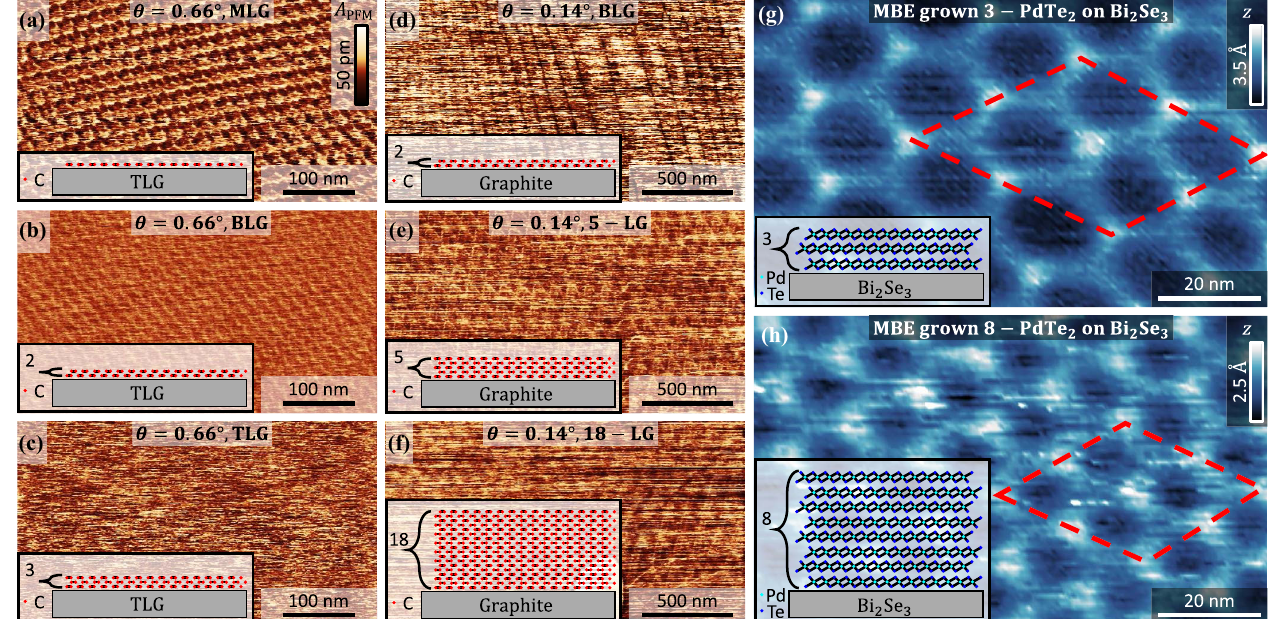
FIG. 2. Experiment motivation: evidence for multilayered relaxation. (a) – (c) PFM amplitude mapping of (a) MLG, (b) BLG, and (c) TLG twisted by 0.65° relative to a TLG substrate. (d) – (f) PFM amplitude mapping of (d) bilayer, (e) five-layered, and (f) 18-layered graphene twisted by 0.14° relative to a graphite substrate. The smaller the twist angle, the thicker the layer through which the moir´e superlattice can be resolved. (g),(h) Topography maps by STM of molecular-beam-epitaxy (MBE)-grown PdTe 2 on a Bi 2 Se 3 substrate. Two thicknesses are presented, three layers (g) and eight layers (h), showing a thickness dependence of the domain structure and the moir´e period indicating a layer-dependent relaxation process. The dashed red diamond marks four moir´e unit cells ( 2 × 2 ) in each case. Inset in each panel presents a schematic of the system under study. The experimental details are presented in Appendixes A and